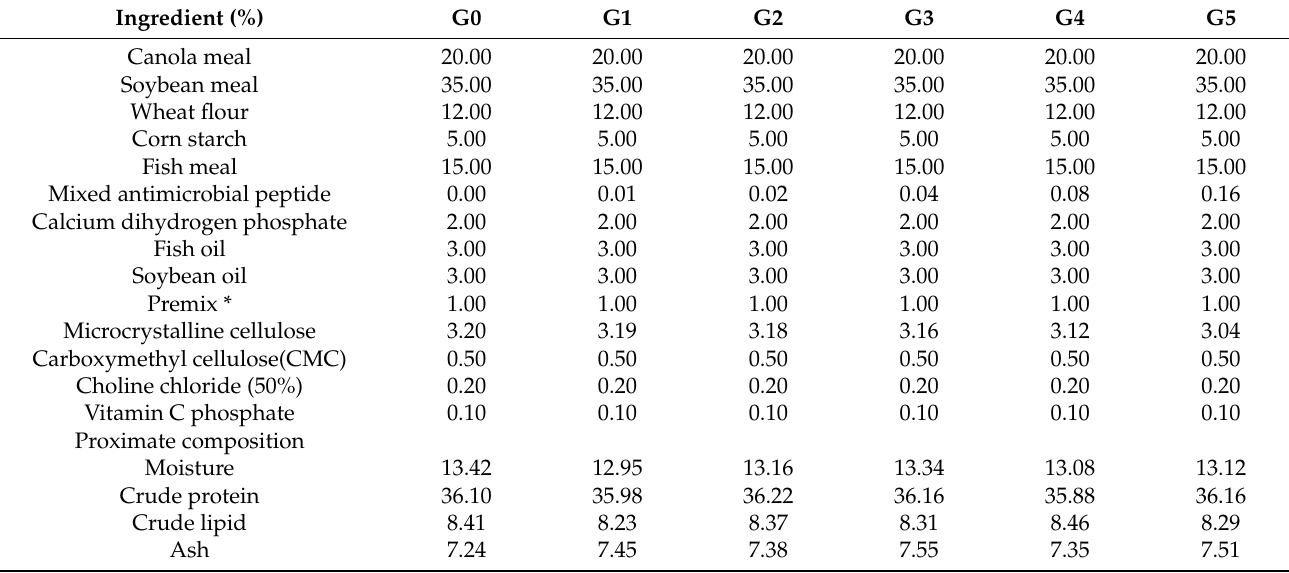
Table 1. Feedstuffs and experimental diets in this